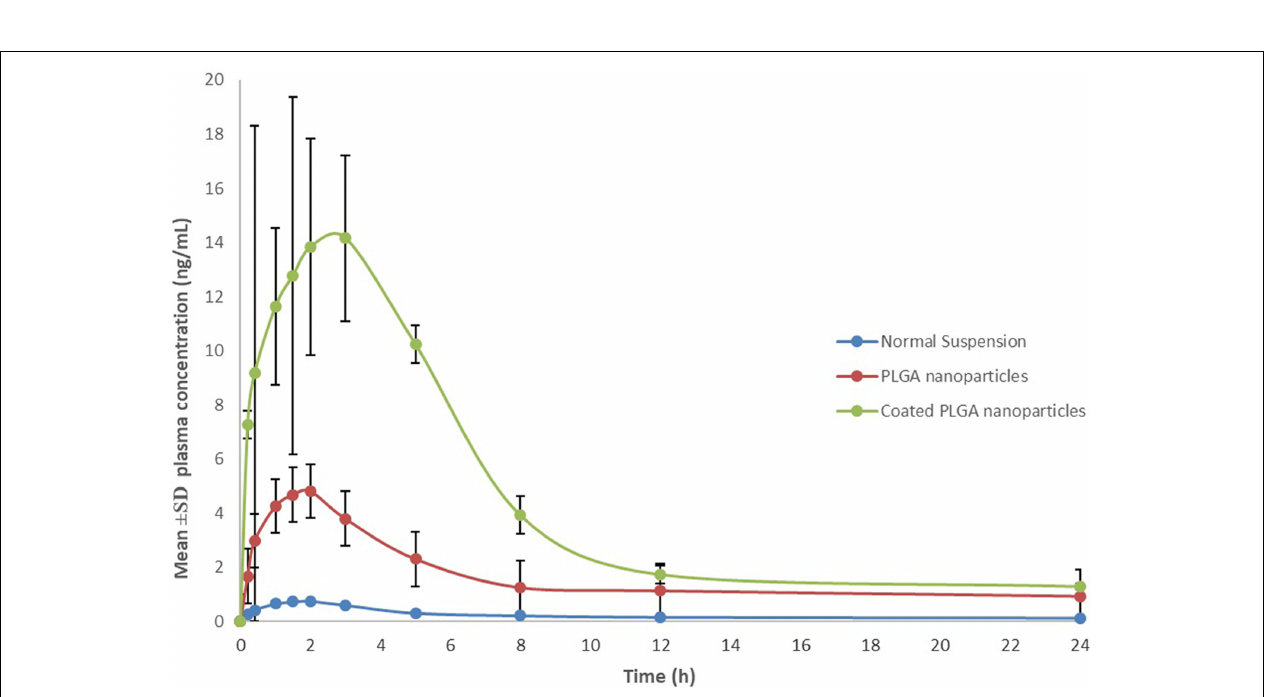
FIGURE 7 | Multiple reaction monitoring (MRM) chromatogram of ELUX and IS in plasma samples after administration of ELUX normal suspension.